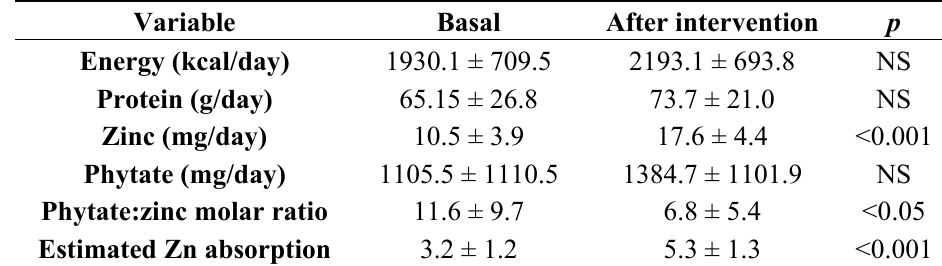
Table 3. Mean dietary intake of energy, protein, zinc, phytate and other parameters in study participants.